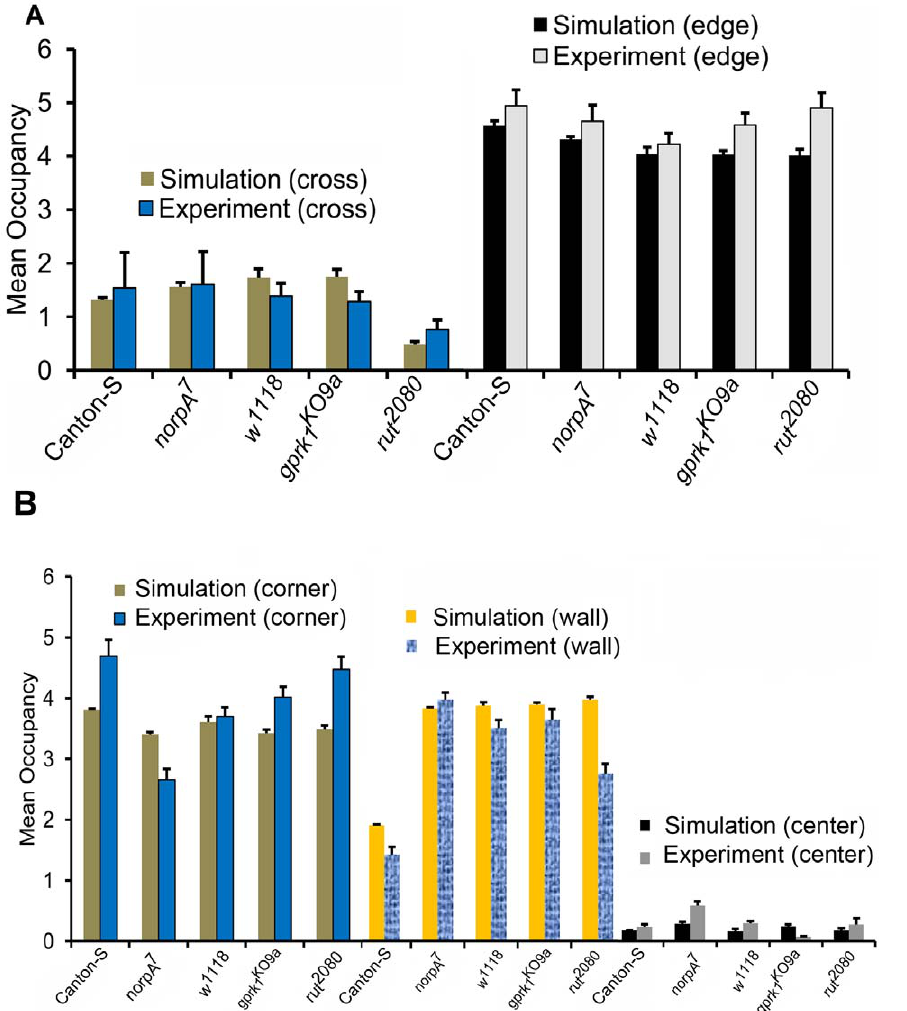
Figure 11. Positional preferences for four genotypes (experiments and simulations) inside a square and internal corner arenas. A. Mean occupancies for four mutant flies and wild type flies in different zones of the inner cross arena are shown. The 4 cm square sector at the center of the arena is the cross zone. The annular region of width 0.6 cm along the boundary comprised the edge zone. B . Mean occupancies for four mutant flies and wild type flies in different zones of 7.2 cm 6 7.2 cm square arena. The three spatial zones: corner, wall and center were divided as showin in Figure 2. The asterix indicates significant difference between simulations and experiments (*: p v 0 : 05 , **: p v 0 : 001 , and ***: p v 0 : 0001 ). Significant differences between simulations and experiments are more prevalent in the square arena. Nevertheless, the simulations produced several trends in the occupancies which were similar to the experiments in both the arenas.